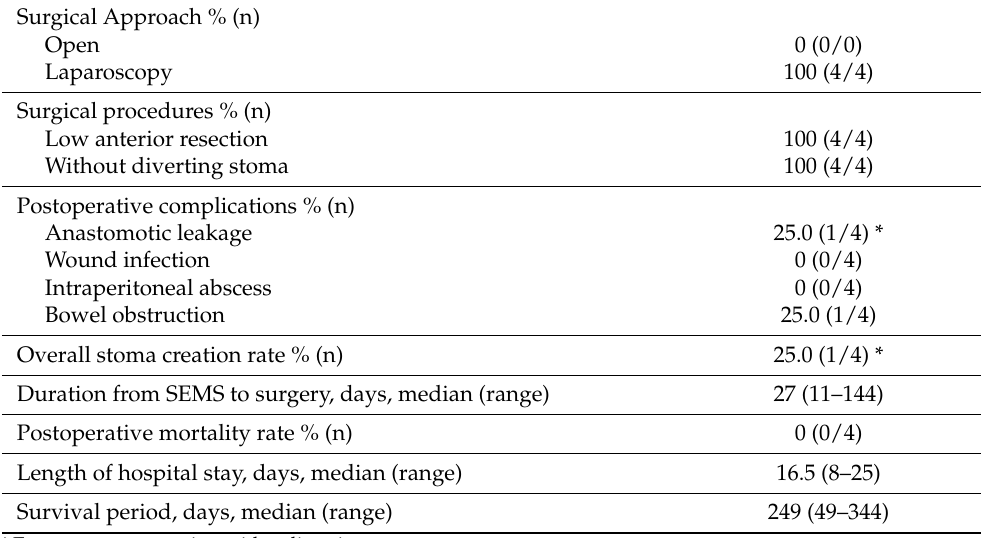
Table 3. Surgical and long-term outcomes in the BTS